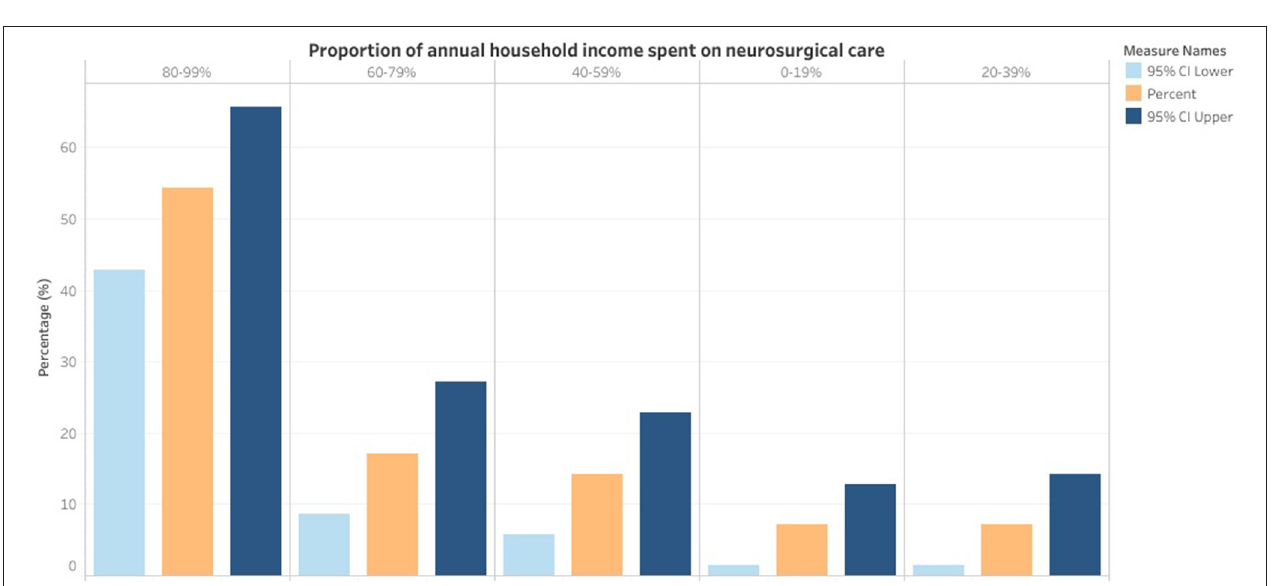
FIGURE 3 | Proportion of the annual household income spent on neurosurgical care.